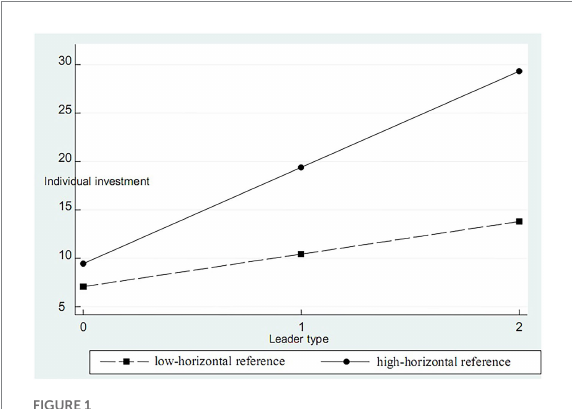
FIGURE 2 Moderator effect of risk preference.